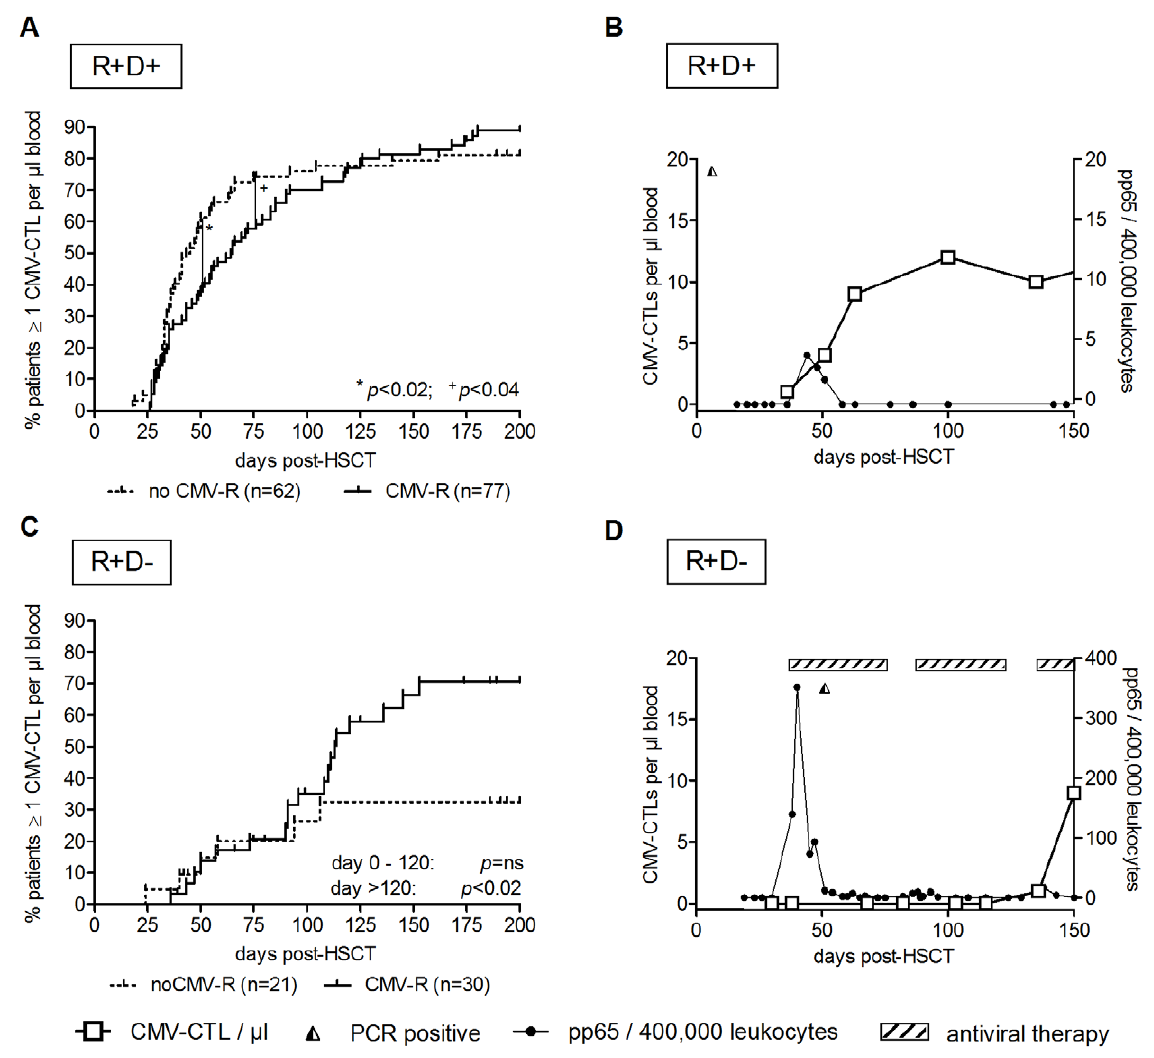
Figure 4. CMV-CTL monitoring enables early discrimination between R + /D + patients in whom CMV reactivation did or did not occur. ( A ) A threshold of 1 CMV-CTL per m l blood was applied to discriminate between patients with and without CMV reactivation in the R + /D + group. P-values from log-rank testing are indicated for days + 50 (*) and + 75 ( + ). ( B ) CMV-CTL reconstitution after HSCT is shown for one patient in the R + /D + group. CMV-CTL numbers per m l blood (left y-axis, empty squares) were plotted against the time in days after HSCT. The right y-axis (filled circles) shows the number of pp65-positive cells/400,000 leukocytes as the means of detecting CMV reactivation. Positive PCR results for CMV are indicated at the top of each graph (half filled triangle). CMV reactivation occurred on day + 39 (spike in filled circle line) in this patient, after which CMV-CTL expansion occurred (rise in empty square line). ( C ) Reconstitution of CMV-CTLs within the R + D 2 group using a threshold of 1 CMV-CTL per m l blood. Until day + 100 no significant reconstitution occurred. ( D ) Prolonged CMV immune reconstitution (empty squares) and necessary prolonged antiviral therapy (striped bar) in one patient from the R + /D 2 group.